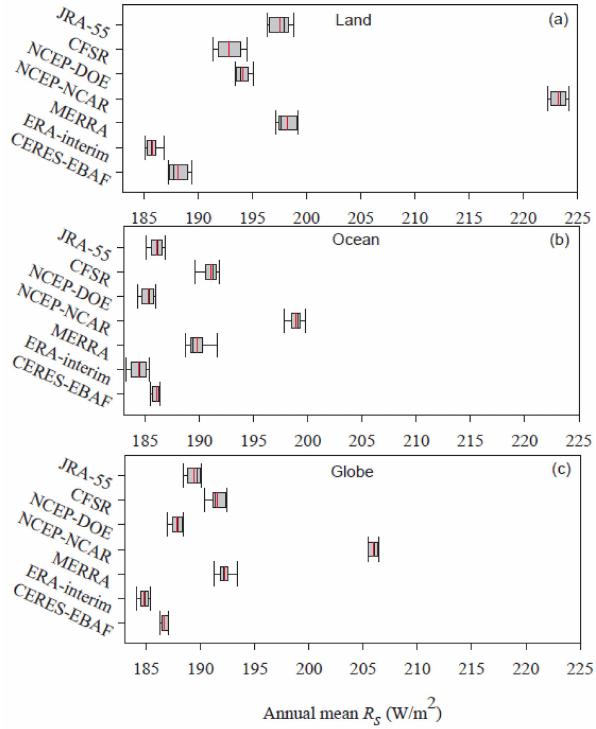
Figure 11. Box plots of the annual mean R s from the global reanalyses and CERES-EBAF data from 2001 to 2009. The red and black lines within the box indicate the mean and median annual mean R s values, respectively: ( a ) land; ( b ) oceans; ( c ) the